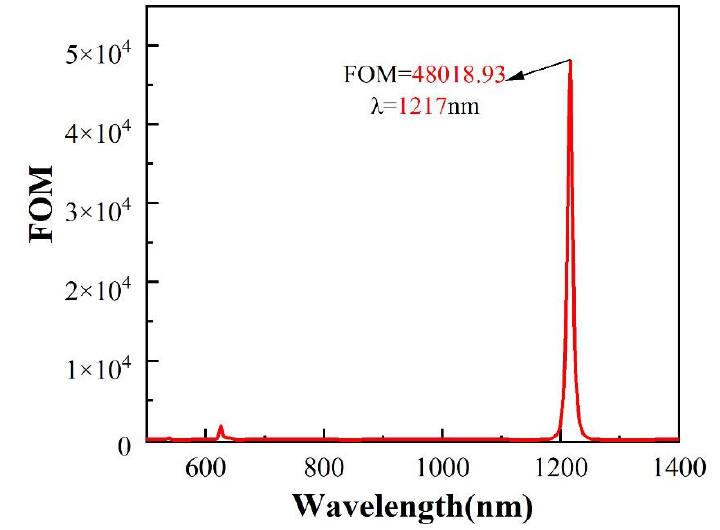
Figure 9. FOM of the designed structure.